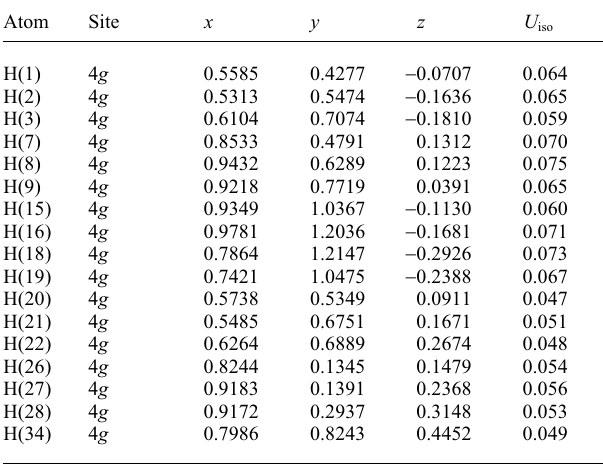
Table 2. Atomic coordinates and displacement parameters (in Å 2 )